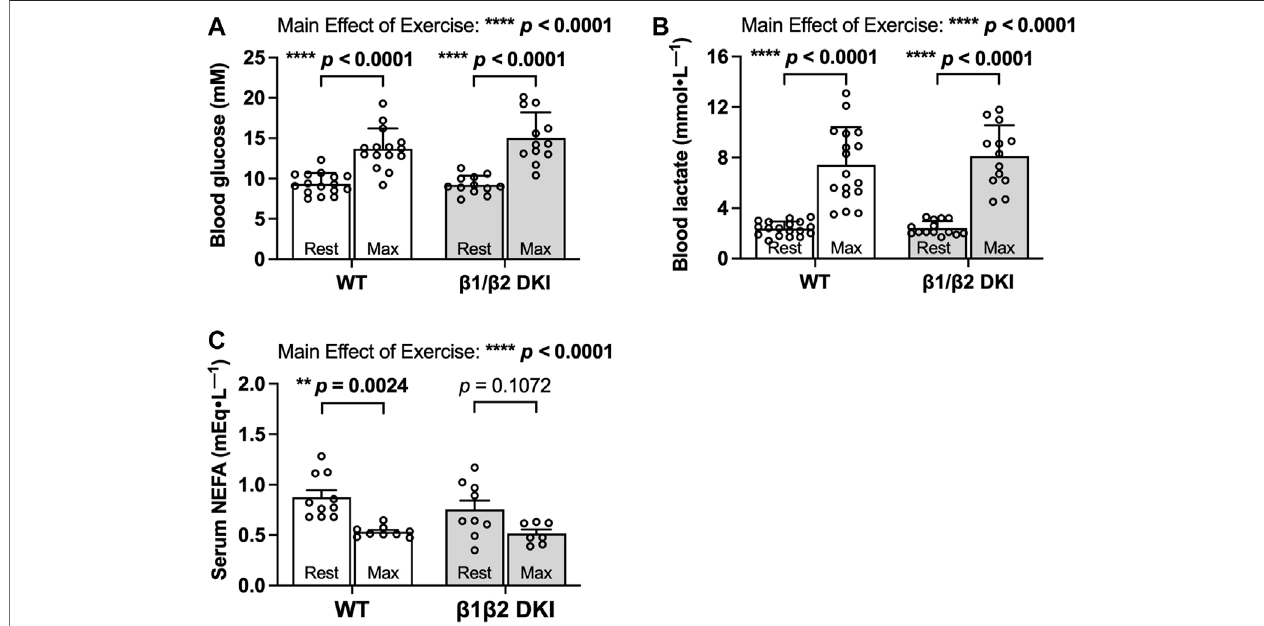
FIGURE3| DKI and WTmice have similar circulating glucose, lactate,and non-esteri fi ed fatty acid(NEFA) levelsfollowingamaximalrunning test at a5 ° incline. (A) Blood glucose and (B) lactate were measured via tail tip bleeding the morning before and immediately following the maximal exercise test at a 5 ° incline. Fed male mice,